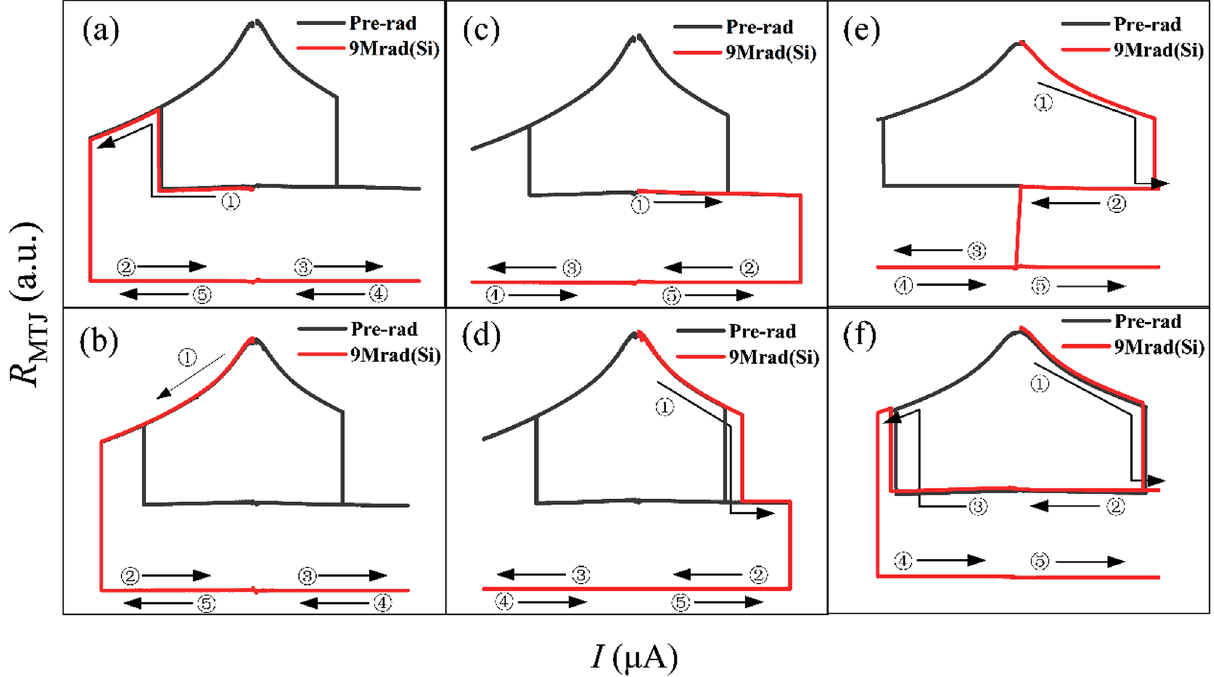
Figure 4. Current induced switching characteristics of MTJ devices before and after 9 Mrad(Si) total ionizing dose radiation with different initial sweep directions and different initial resistance. ( a ) negative sweep from initial low resistance state, ( b ) negative sweep from initial high resistance state, ( c ) positive sweep from initial low resistance state, ( d ) positive sweep from initial high resistance state, ( e ) positive sweep from initial high resistance state, ( f ) CIMS curves remained complete if sweep region shrank.